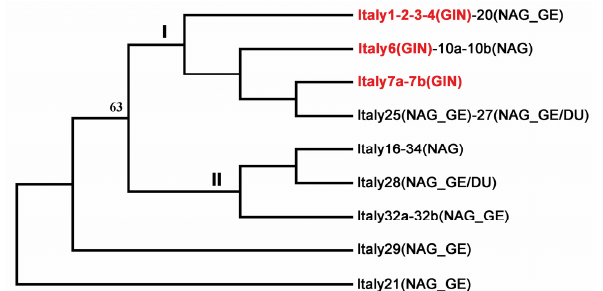
Figure 5. Maximum parsimony (MP) tree of the vacA s1a genotypes found in the present study. The MP method split the tree into two subclades, designated I and II (bootstrap value: 63%), highlighting a subclustering structure of the vacA s1a cluster. All the GIN-associated Helicobacter pylori sequences (red) were included in subclade I of clade s1a, suggesting strict evolutionary relationships. The MP tree was obtained using the Close-Neighbor-Interchange algorithm with search level 3, in which initial trees are generated by random addition of sequences (100 replicates). The bootstrap consensus tree, inferred from 1000 replicates, represents nine genotypes found in the Helicobacter pylori strains retrieved from 20 gastro-duodenal lesions. Multiple infections showing the same vacA s1a sequence are indicated with "a" and "b" in the strain designation. Concomitant lesions (non-atrophic gastritis alone (NAG), NAG plus duodenal ulcer (NAG_DU), and NAG plus gastric erosions (NAG_GE) are in brackets.